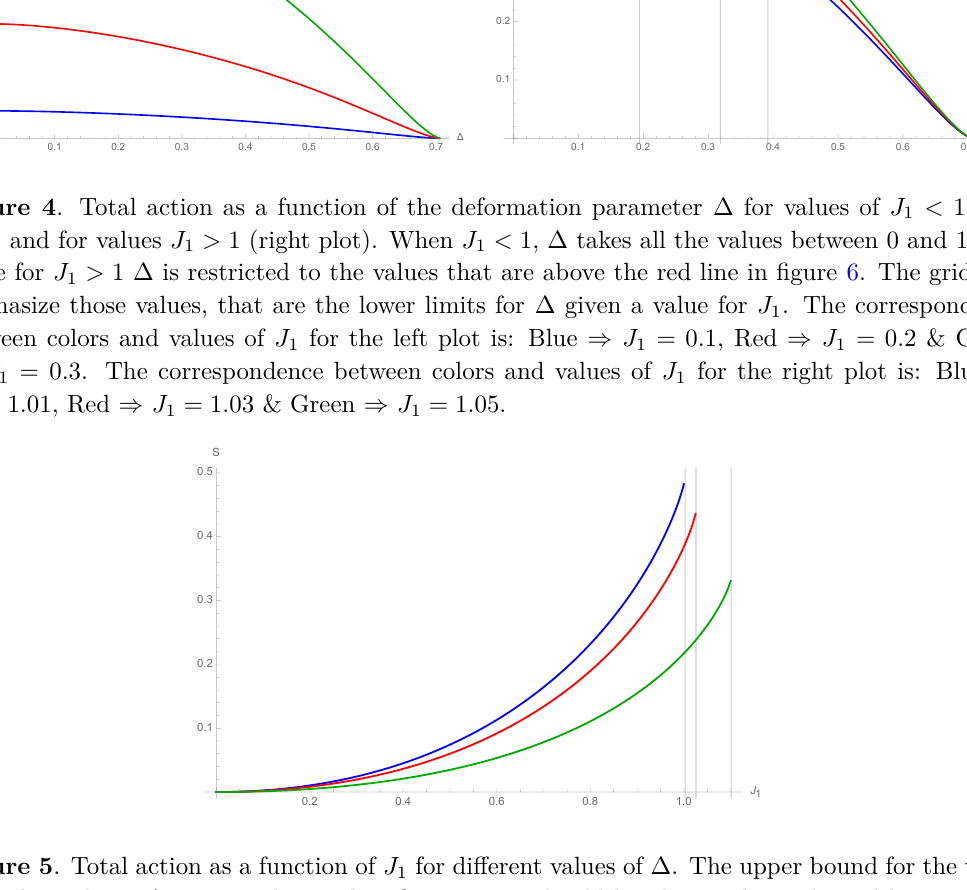
should be always above the red line and the 1 . The correspondence between colors and values of 1